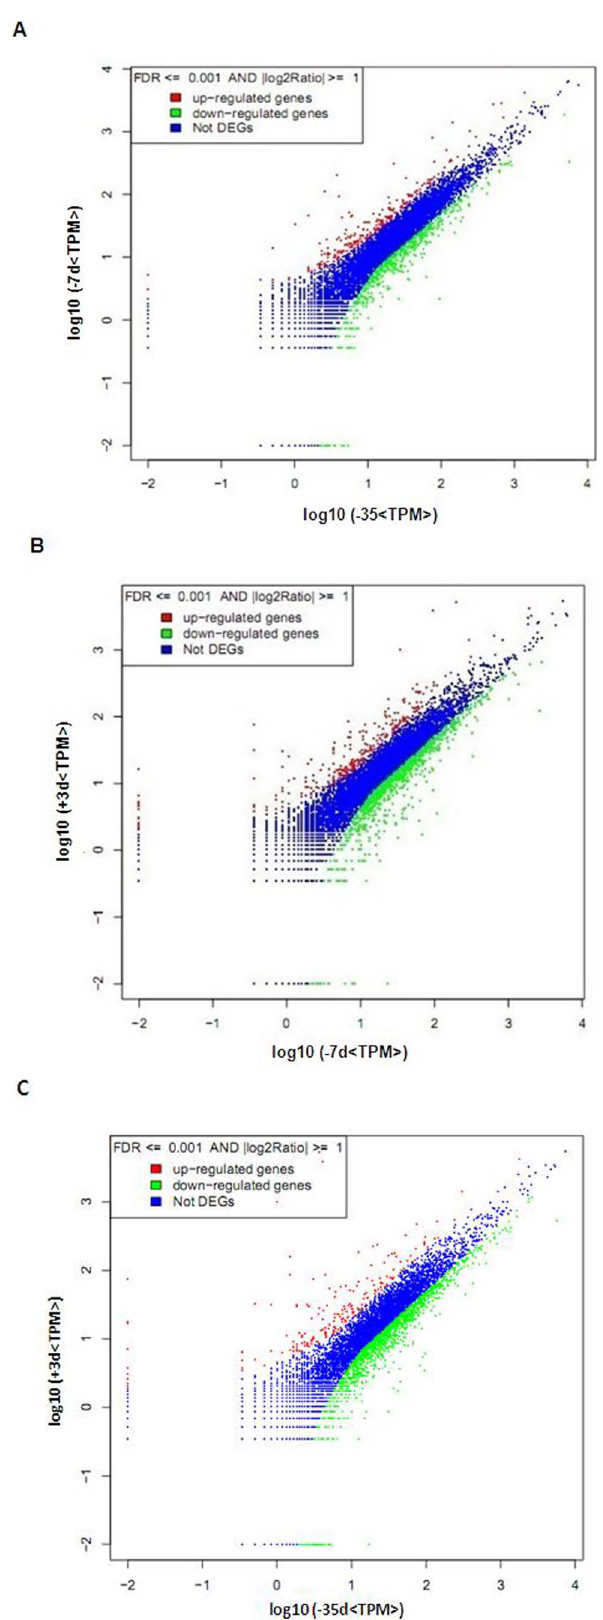
Figure 3. Pairwise comparisons of the level of gene expression between libraries. To compare the level of gene expression between two libraries, each library was normalized to TPM. (A) Differentially expressed genes at 2 7 d compared with 2 35 d. (B) Differentially expressed genes at + 3 d compared with 2 7 d. (C) Differentially expressed genes at + 3 d compared with 2 35 d. Red dots represent upregulated transcripts. Green dots represent downregulated tran- scripts. Blue dots represent transcripts that did not change significantly. The parameters FDR # 0.001 and |log2 Ratio| $ 1 were used as the threshold to judge the significance of the difference in gene expression. See supplementary data 1, 2 and 3 for details of these differentially expressed